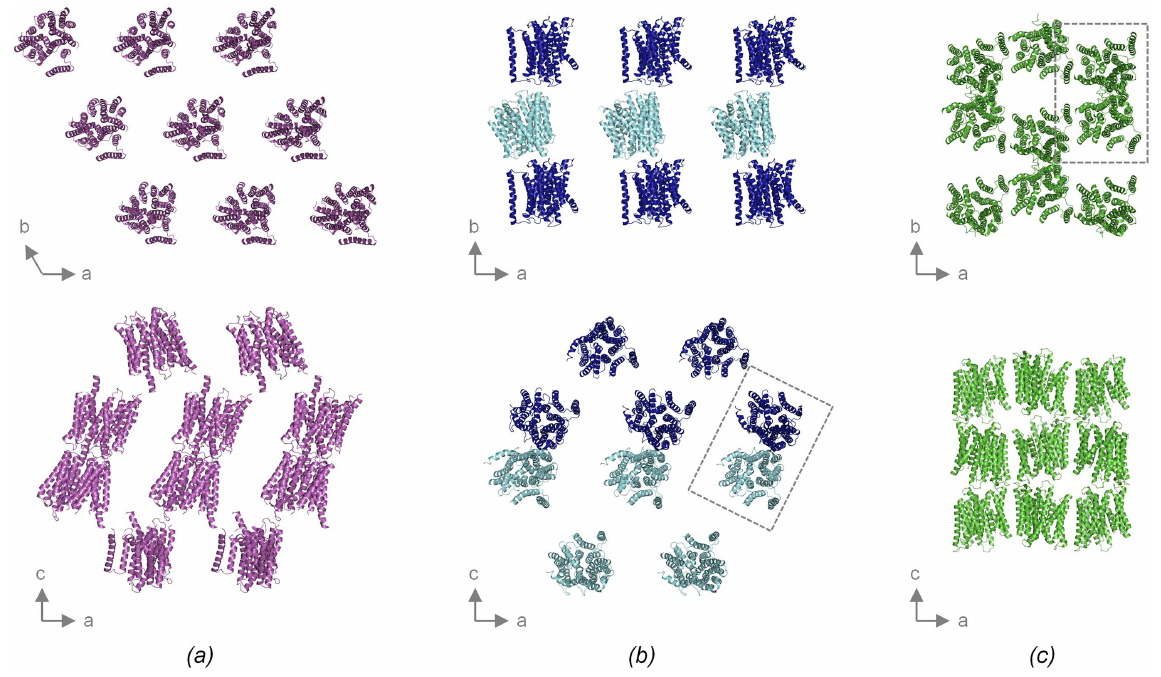
Fig 4. Comparisons of crystalpacking. (a) Crystal packing in the P3 1 21 form. Top: slice of the crystal taken parallelto the (a-b) - planeand encompassingone layer of molecules.The PepT St moleculesare colored magenta. Bottom: slice of the crystal taken parallelto the (b-c) -plane. (b) Crystal packingin the P2 1 2 1 2 1 form (PDB: 4APS). Depictedas in panel a , except that the two molecules in the asymmetric unit are colored light and dark blue, and that the dimer formed by these are boxed. (c) Crystal packing in the C222 1 form (PDB: 4D2C). Depictedas in panel a , except that the moleculesare colored green, and that a dimer with the same arrangement as seen in the P2 1 2 1 2 1 form is similarlyboxed, though this dimer is generatedby crystal symmetry rather than being non- crystallographic.Crystal packinginterfaces are shown in S1